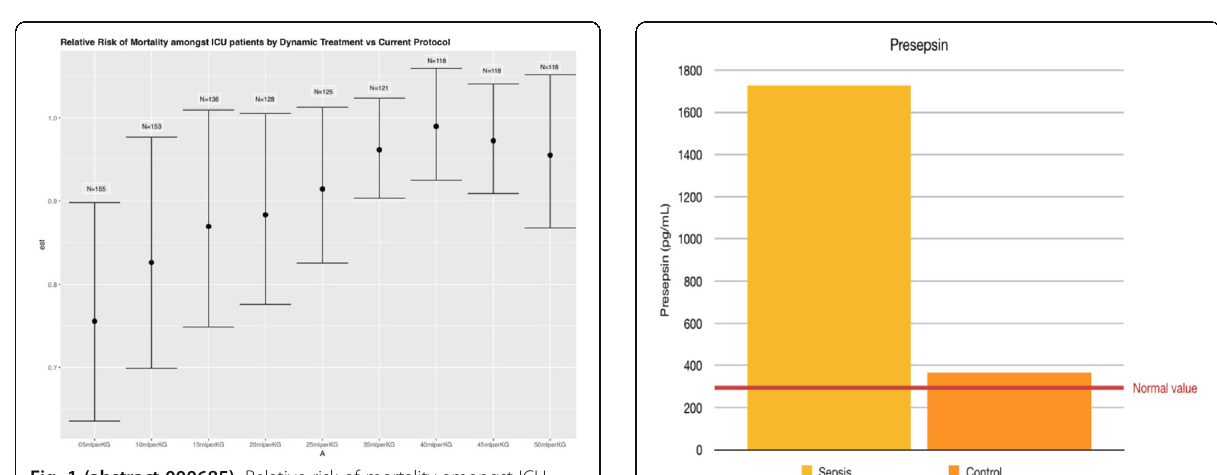
Fig. 1 (abstract 000685). Relative risk of mortality amongst ICU patients by Dynamic treatment vs current protocol Fig. 1 (abstract 001692). See text for description